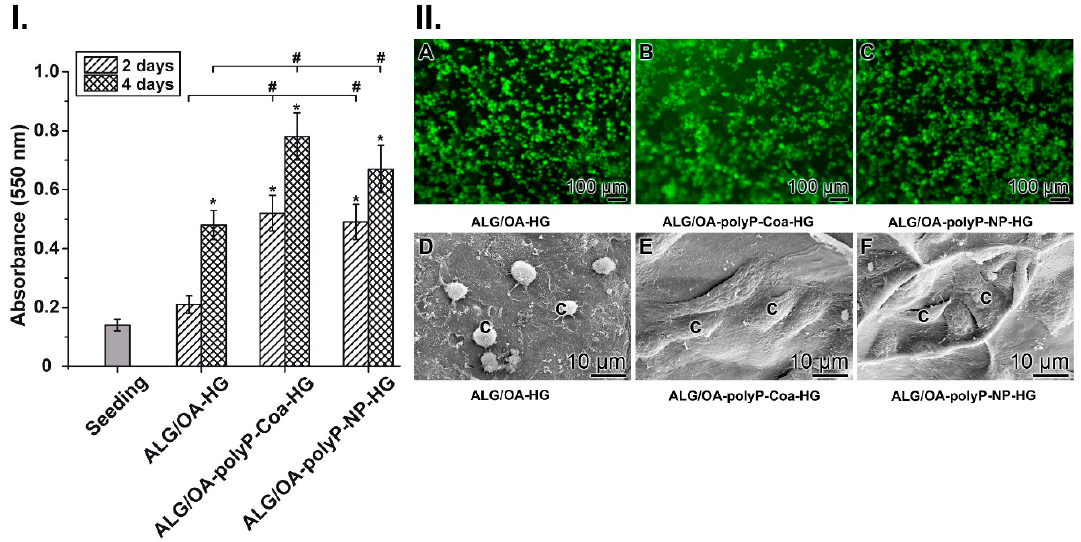
Figure 5. Viability of cells on the hydrogels. ( I. ) MTT analysis to assess the growth/viability of the keratinocytes. The cells were cultivated onto “ALG/OA-HG”, “ALG/OA-polyP-Coa-HG” or “ALG/OA-polyP-NP-HG” matrices. The viability/cell number was determined after an incubation period of 2 d or 4 d. Then the cells were reacted with MTT and the intensity of the formed formazan dye was measured with a microplate reader at 550 nm. Ten parallel assays per point were performed. The data represent means ± SD. The significances within an individual group (*; p < 0.01) were calculated. The significances with respect to the assays without polyP are likewise marked (#; p < 0.01). ( II. ) Microscopic analysis of the cells onto the respective gels, “ALG/OA-HG”, “ALG/OA-polyP-Coa-HG” or “ALG/OA-polyP-NP-HG”, after an incubation period for 4 d. In A to C the cells were vitally stained with calcein and inspected with a fluorescence microscope. In D to F the cells were visualized by ESEM.